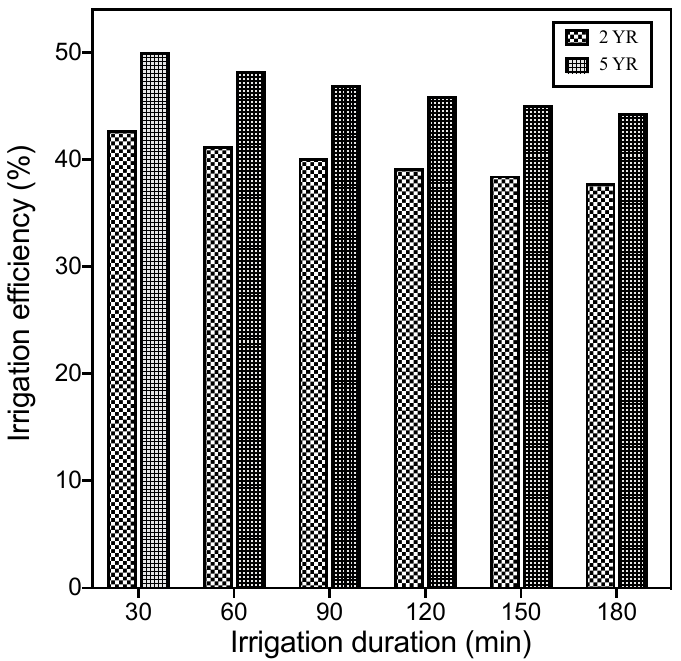
Figure 4. Reduction of water amount absorbable for periods of irrigation up to 3 h in 2YR and 5YR plots if compared with the benchmark plot (0YR).